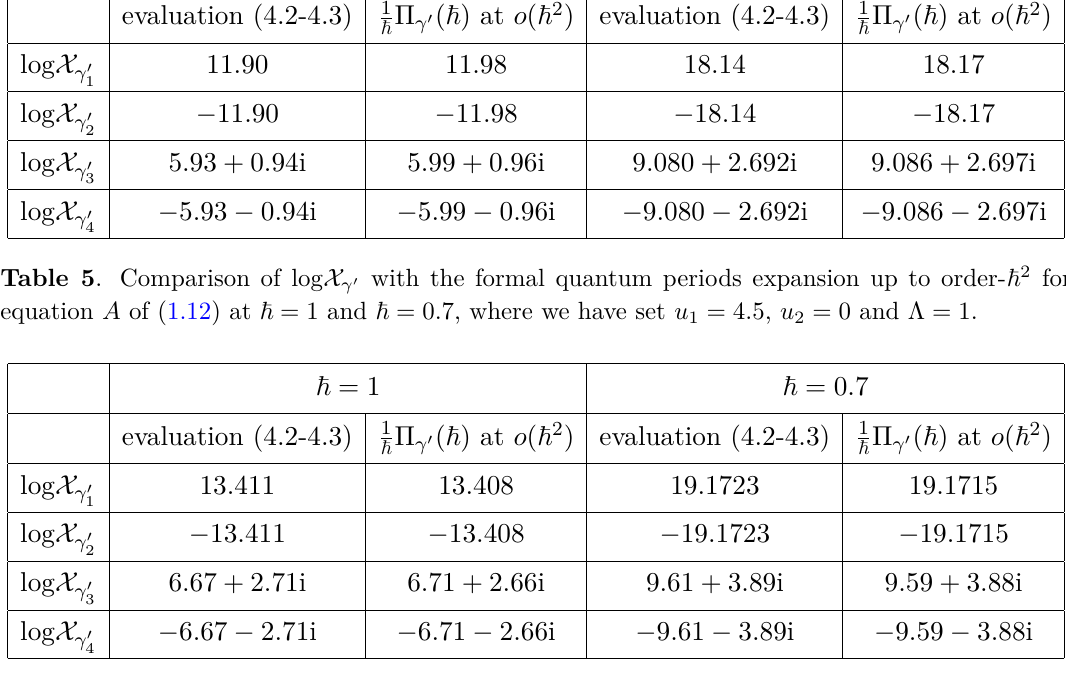
= 4 . 5 , u = 0 and Λ = 1 1 2